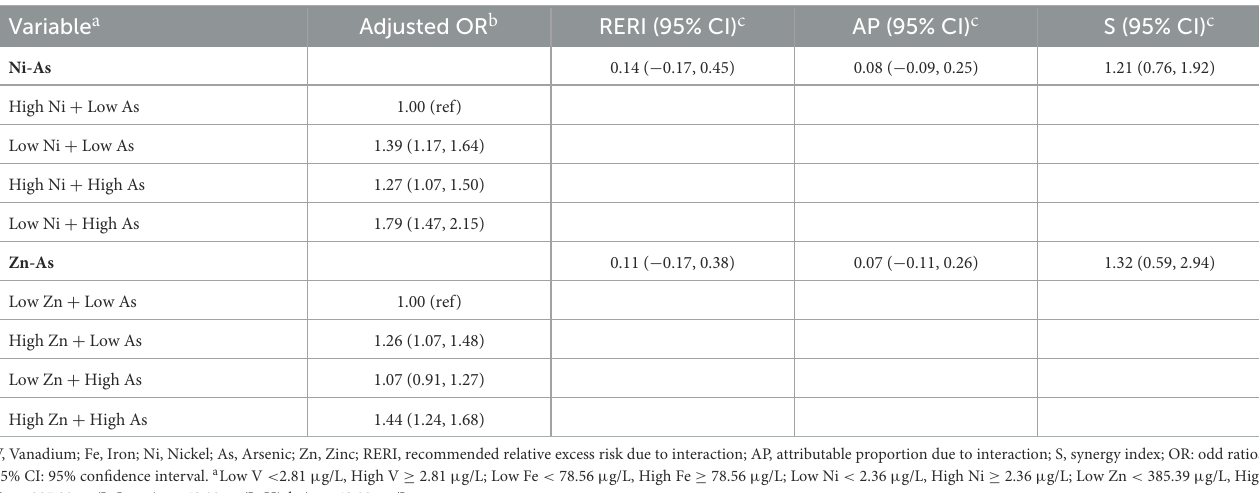
via urine, and non-invasive and convenience in collection of urine sample. Finally, the cross-sectional study is unable to identify the causal relationship between multiple metals exposure levels of the body and HUA. Further prospective studies are needed to validate the